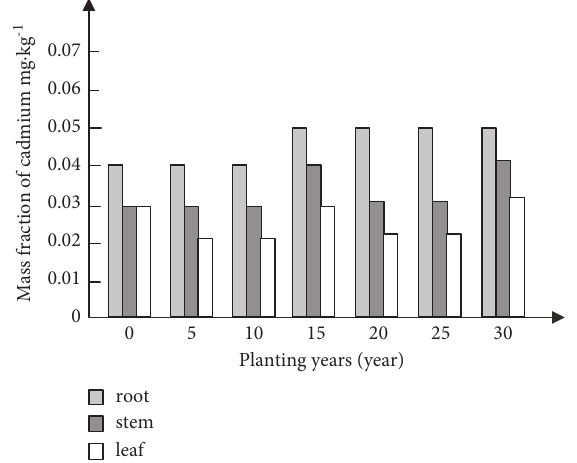
Figure 4: The characteristics of greenhouse vegetable soil with different planting years of cadmium absorption and accumulation of